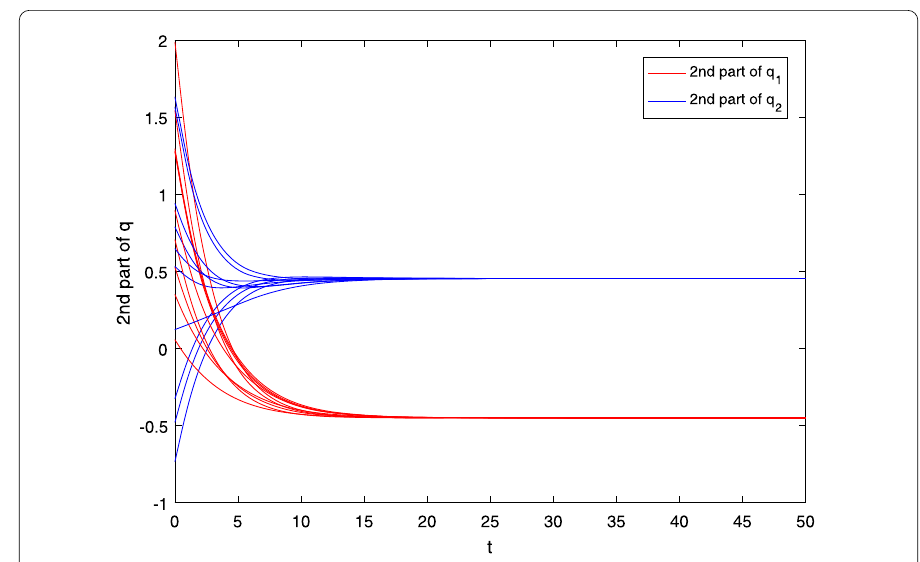
Figure 2 The second part of the state trajectories for system (1) with parameters (27)